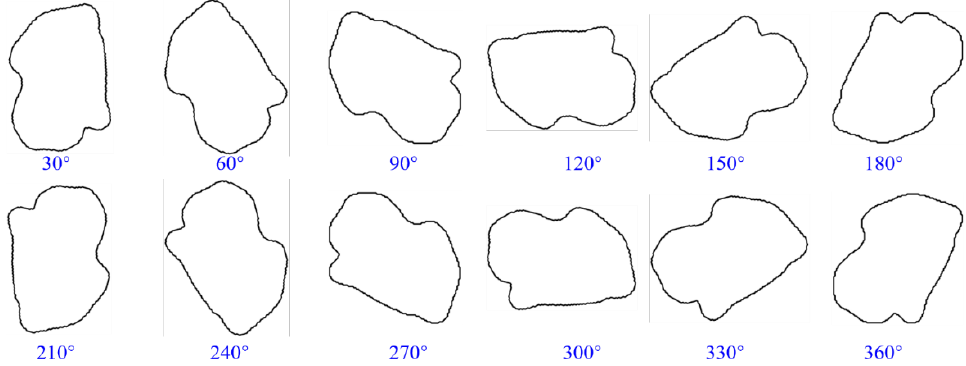
Figure 11. The results of grain orientation change.